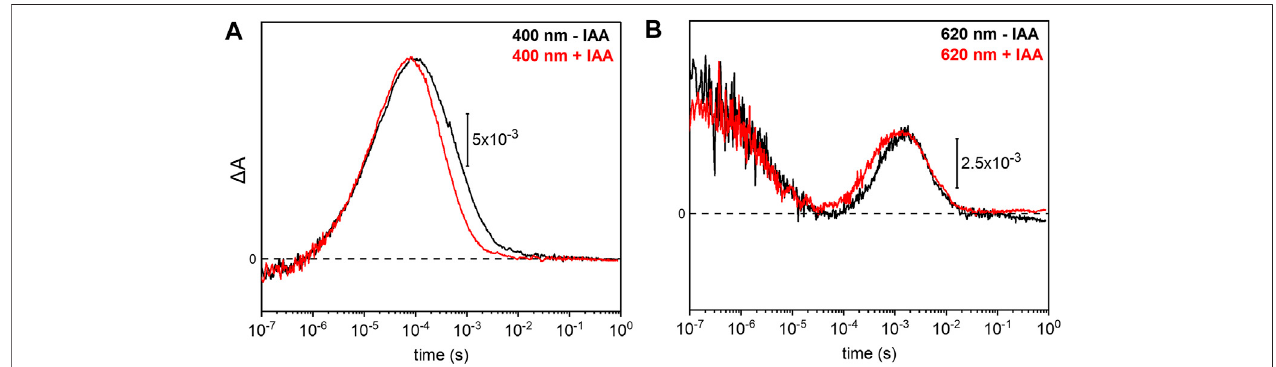
FIGURE 6 | Impact of indole-3-acetic acid (IAA) on the M-O transition of Um Rh1. Kinetic traces of the fl ash-induced absorption changes recorded at (A) 400 nm and (B) 620 nm of DDM-solubilized Um Rh1 (100 mM NaCl, 100 mM MES, pH 5.5 and 0.03% DDM) (black lines) and DDM-solubilized Um Rh1 in presence of 20 mM IAA, in the same buffer (red lines), is shown. Great care was taken to perform both measurements at the exact same pH. Experiments have been repeated on three independent samples yielding the same results.